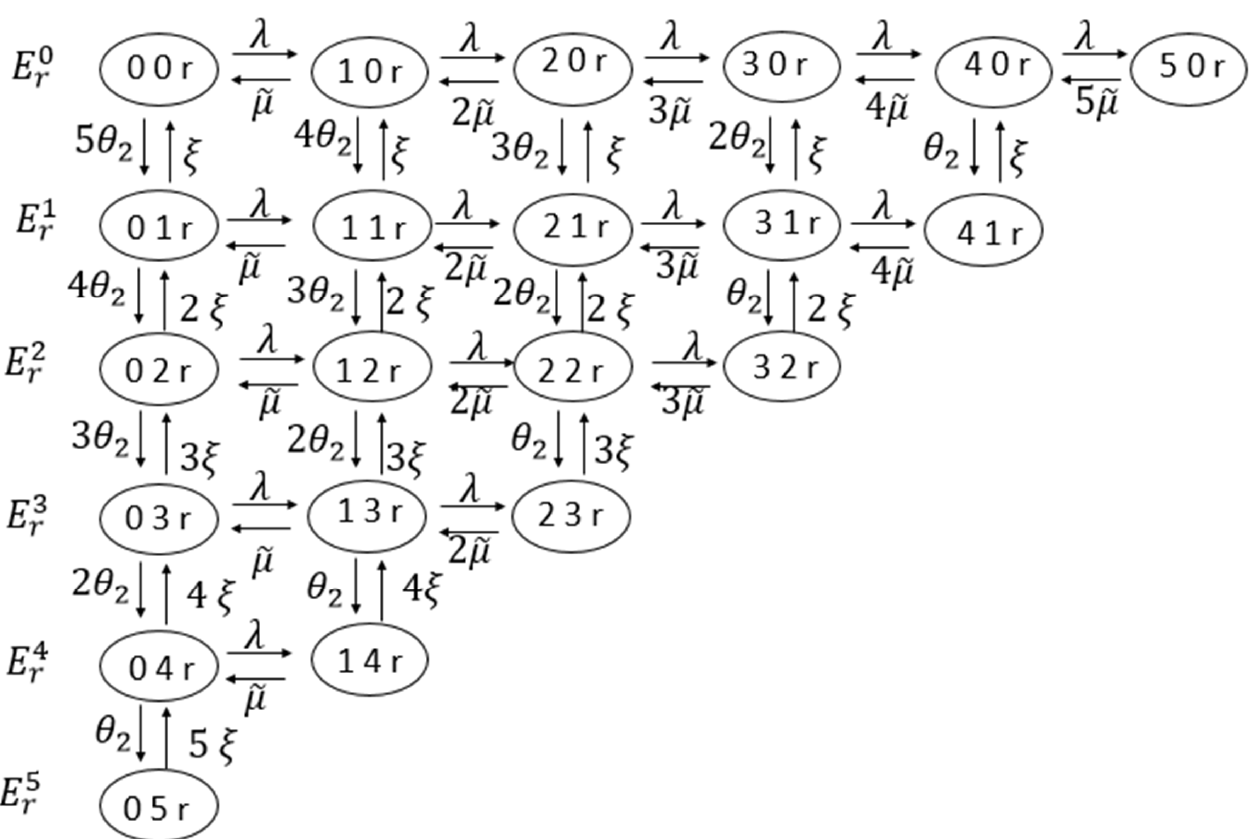
Figure 2. State diagram for the split model with SS E r , K = 5.